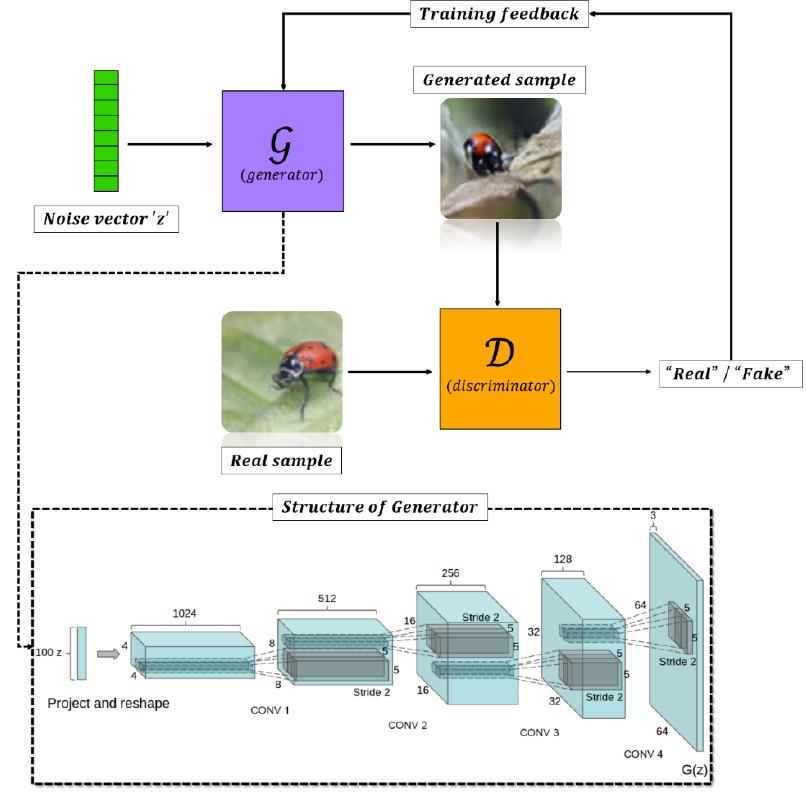
Figure 1. DCGAN (Deep Convolutional Generative Adversarial Network) generator used for LSUN (Large-Scale Scene Understanding) [11].